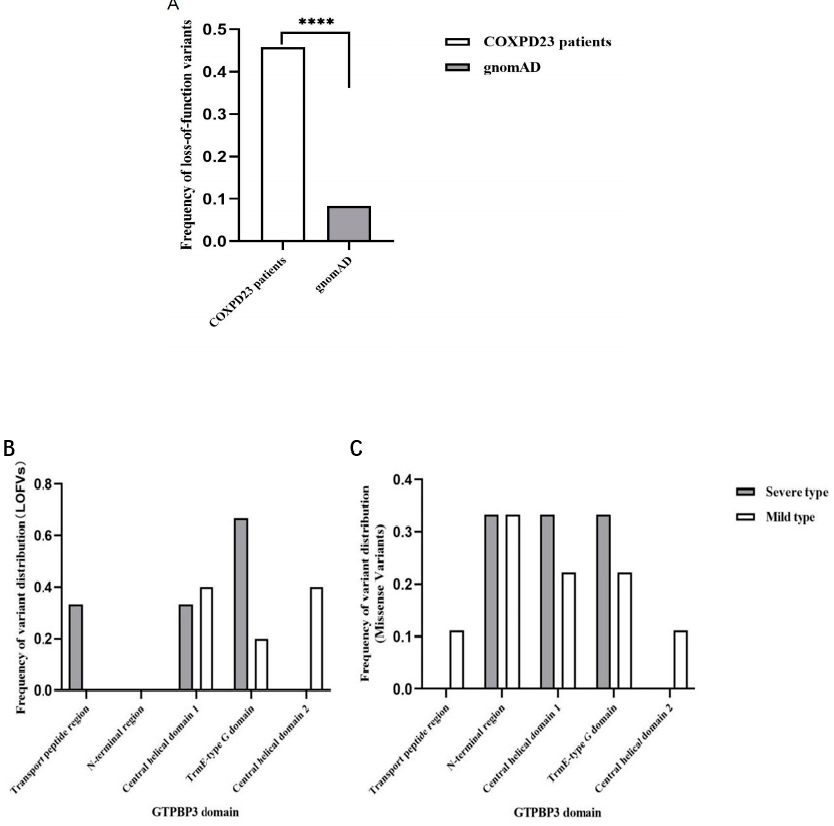
Figure 5. Comparison of the types of GTPBP3 variants and their distributions in different domains. ( A ) Comparison of the frequency of loss-of-function variants between COXPD23 patients and general populations ( n = 260) ( p < 0.0001 ****); ( B ) Frequency of LOFV distribution in different domains between two groups ( n = 8); ( C ) Frequency of missense variant distribution in different domains between two groups ( n = 15).